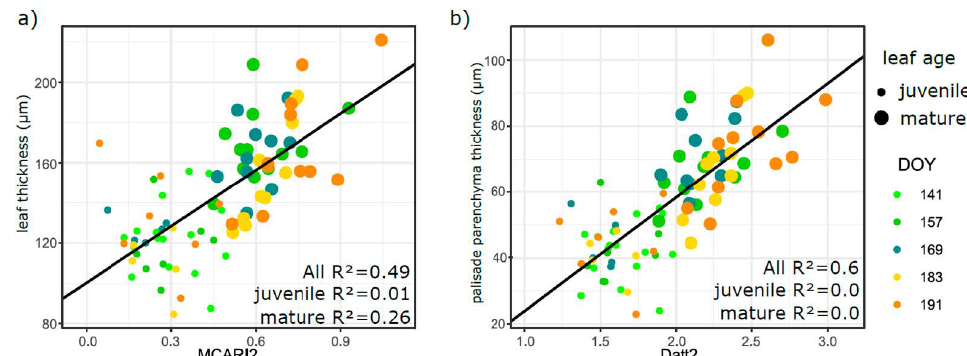
Figure 11. Linear relationship between best-performing vegetation index and a leaf anatomical trait ( a ) MCARI2 index (1.2*(2.5*(R800.5 − R669.8) − 1.3*(R800.5 − R549.6))) and leaf thickness; ( b ) Datt2 (R849.9/R709.1) and palisade parenchyma thickness. Different size of circles corresponds to leaf age (juvenile—small, mature leaves—big). Different colors correspond to individual DOYs during the season. Coefficient of determination (R 2 ) is shown for all leaf developmental stages pooled together (All); juvenile, mature separately.